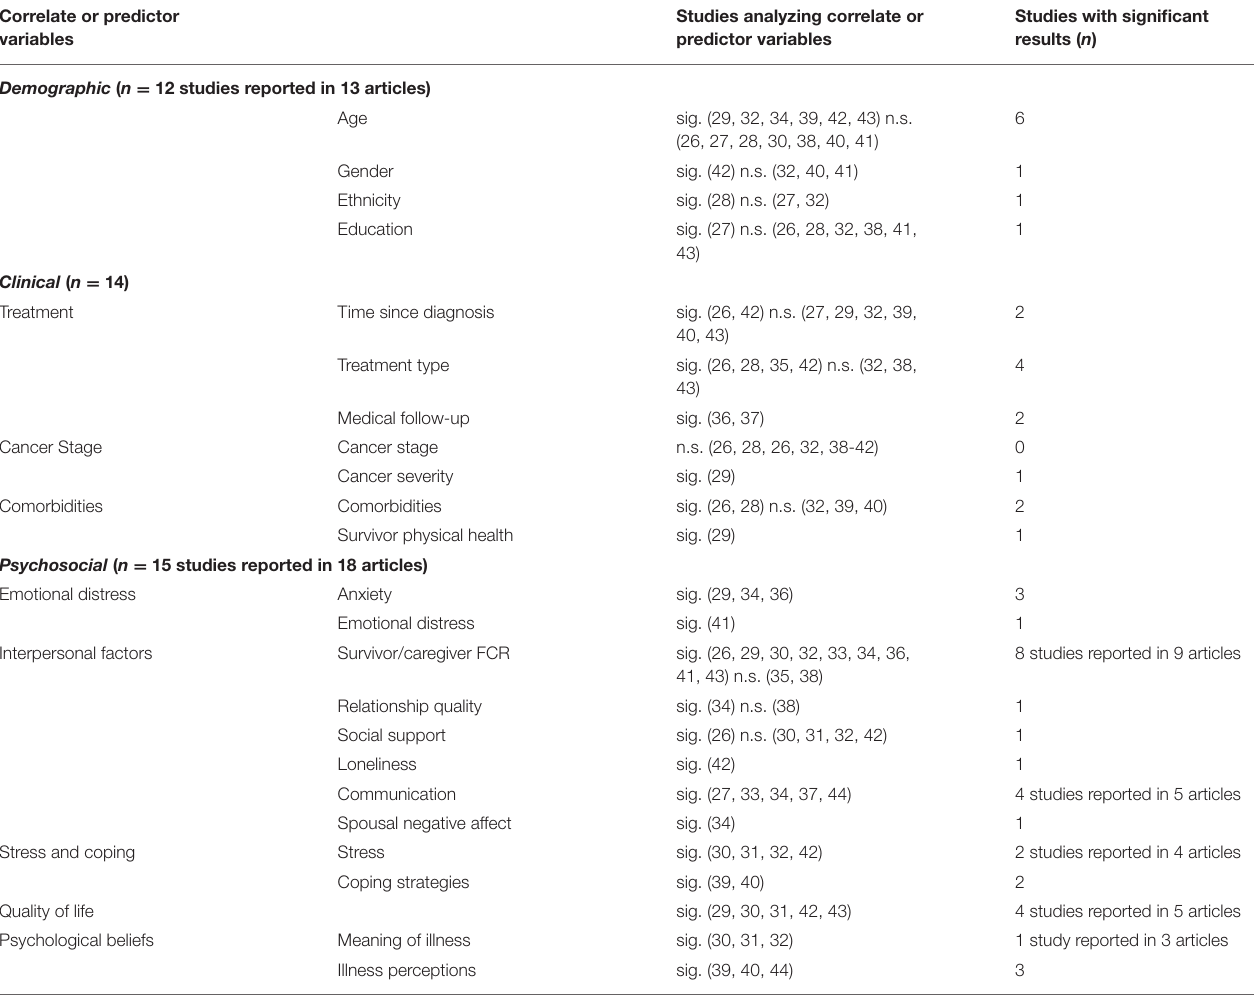
TABLE 1 | Measures of demographic, clinical, and psychosocial factors. Correlate or predictor variables